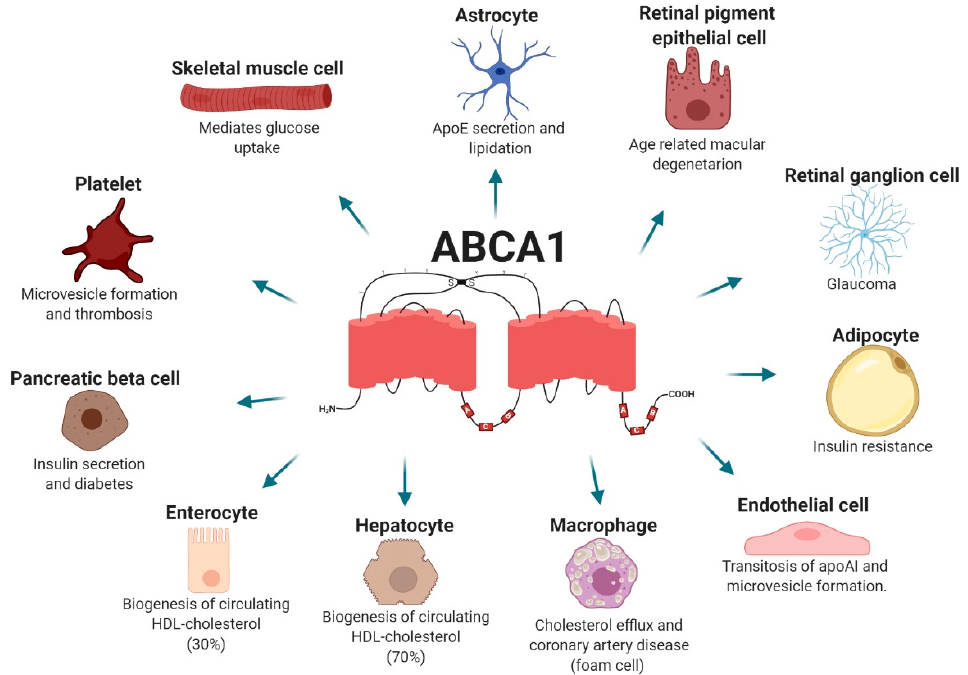
Figure 1. ATP-binding cassette transporter A1 (ABCA1) functions in different cell types and associated diseases. ABCA1 is widely expressed and participates in a broad array of physiological and pathological processes. ApoE: apolipoprotein E; HDL: high-density lipoproteins; apoAI: apolipoprotein I.